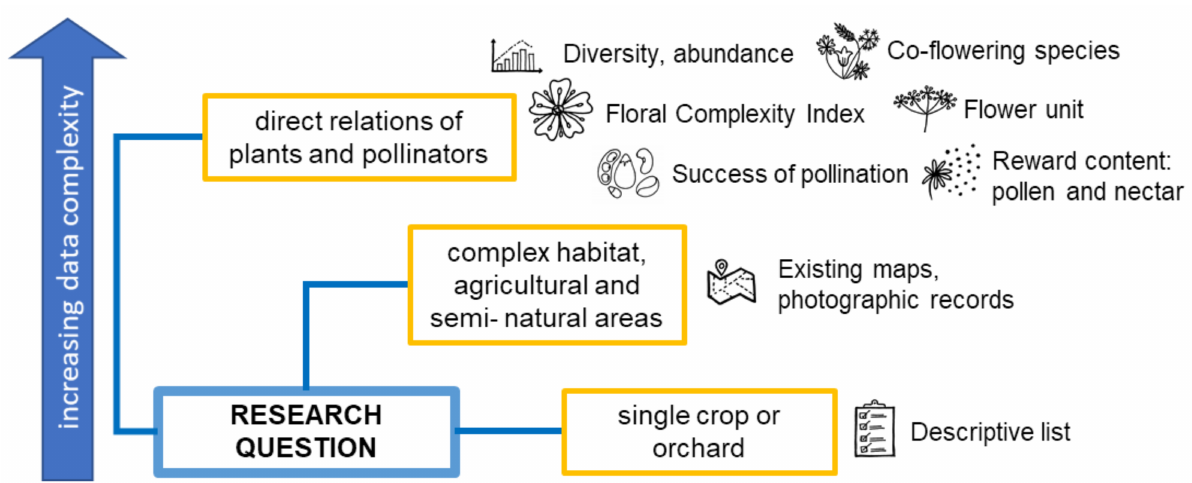
Figure 3. Levels of complexity of vegetation. The different ways of describing vegetation, with increasing levels of detail, as addressed in Section